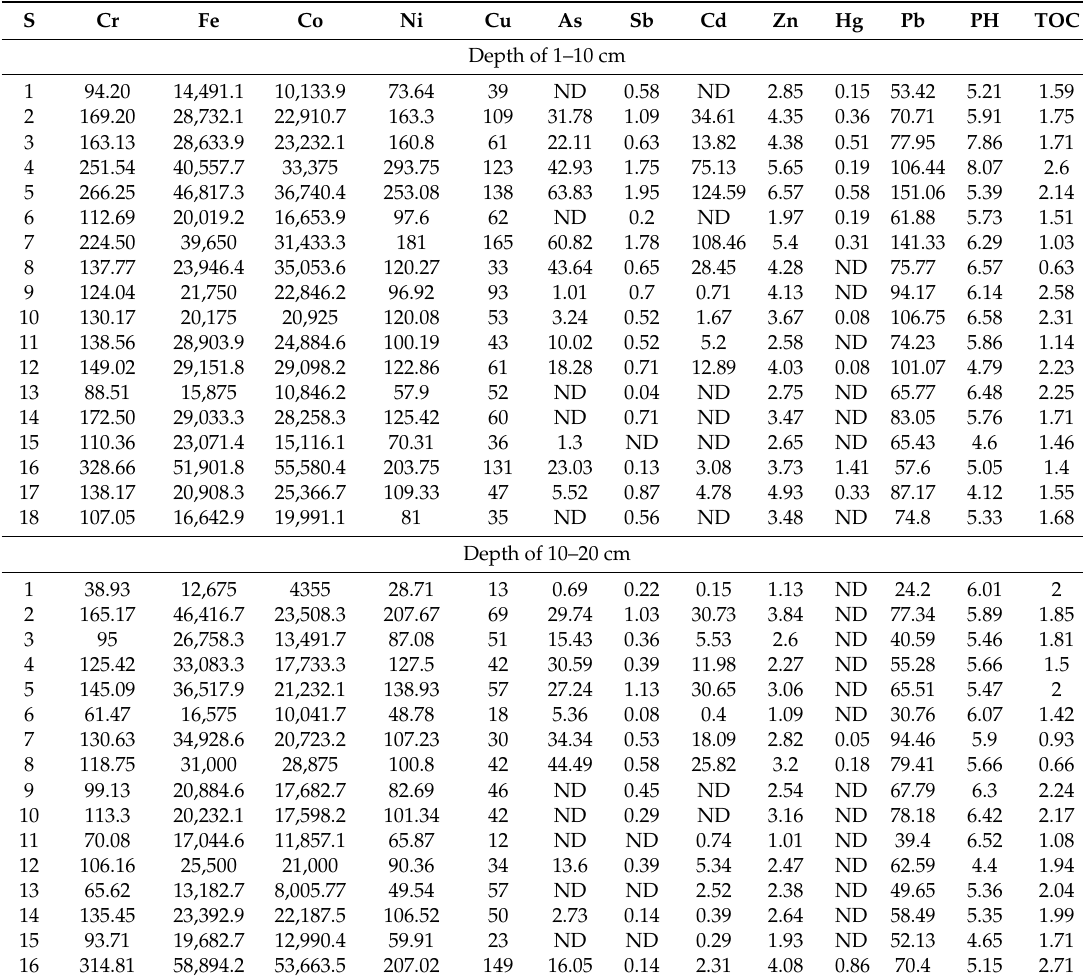
Table 3. The concentration of trace elements (mg/kg), soil pH and TOC for each sample at soil depths of (1–10 and 10–20